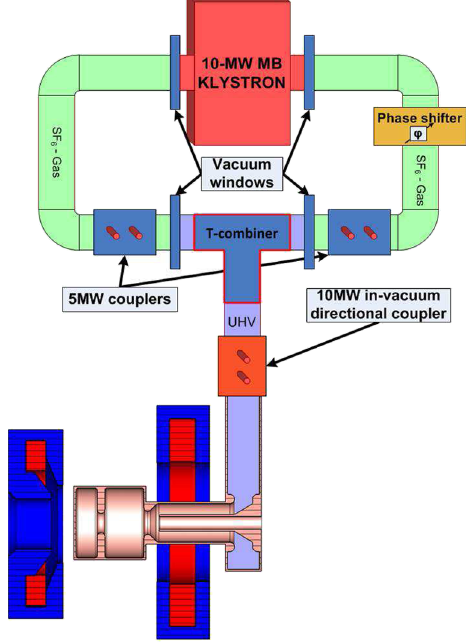
FIG. 2. Schematic diagram of the rf gun power